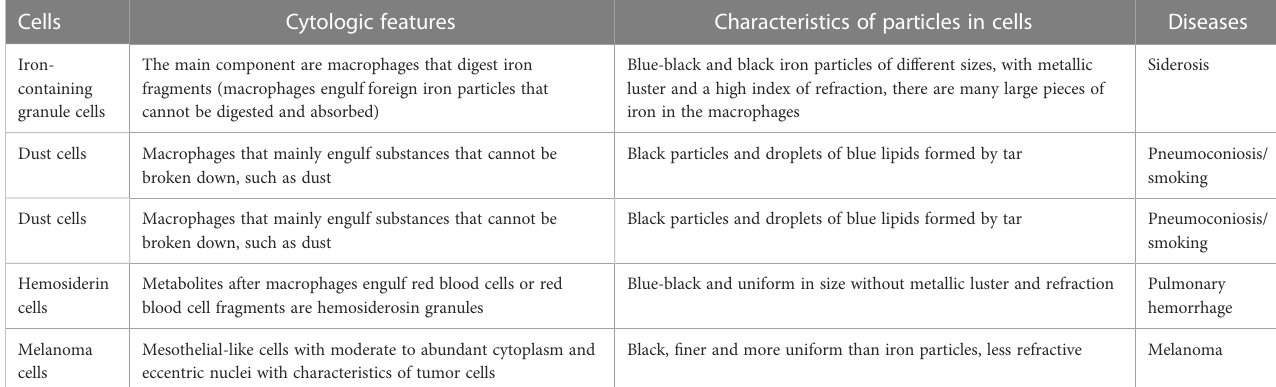
TABLE 1 Cytological characteristics of iron-containing granules, dust cells, hemosideranocytes, and melanocytes, differences in particles in cells, and suggestive